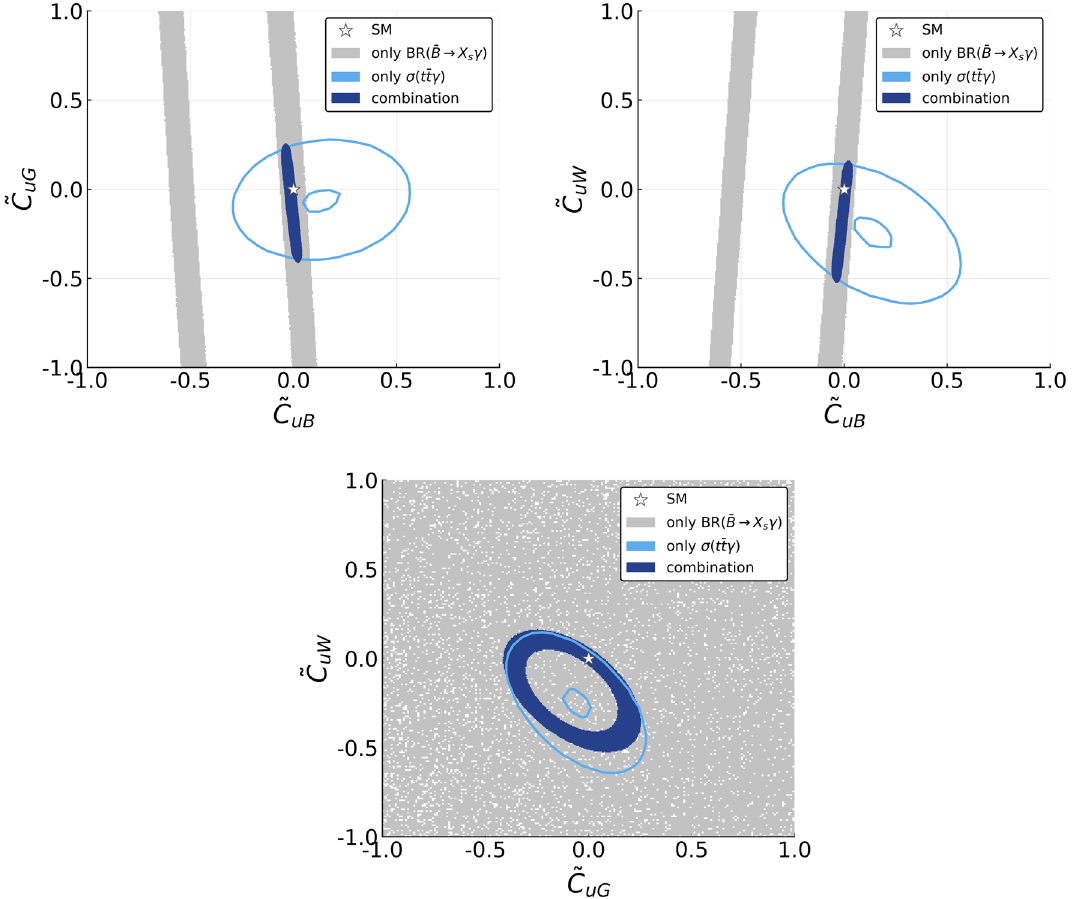
Fig. 10 Comparison of the smallest intervals containing 90% of the 2D marginalized posterior probability distributions for the fits of all three Wilson coefficients using only the measurement of BR( ¯ B → X s γ ), only the measurements of σ( t ¯ t γ) and for the combination. The SM values are